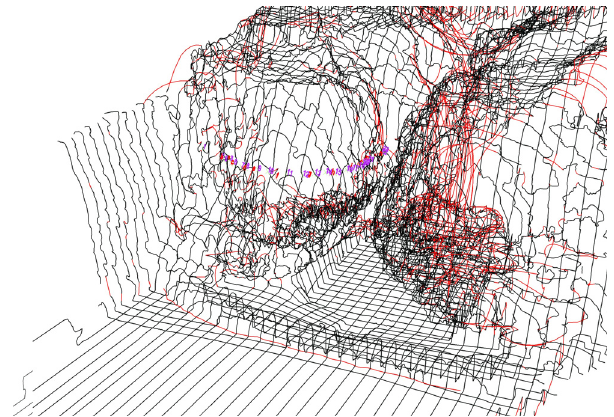
Figure 10. Digital photogrammetry to calcolate the 3d position of the seismic tomography sensor